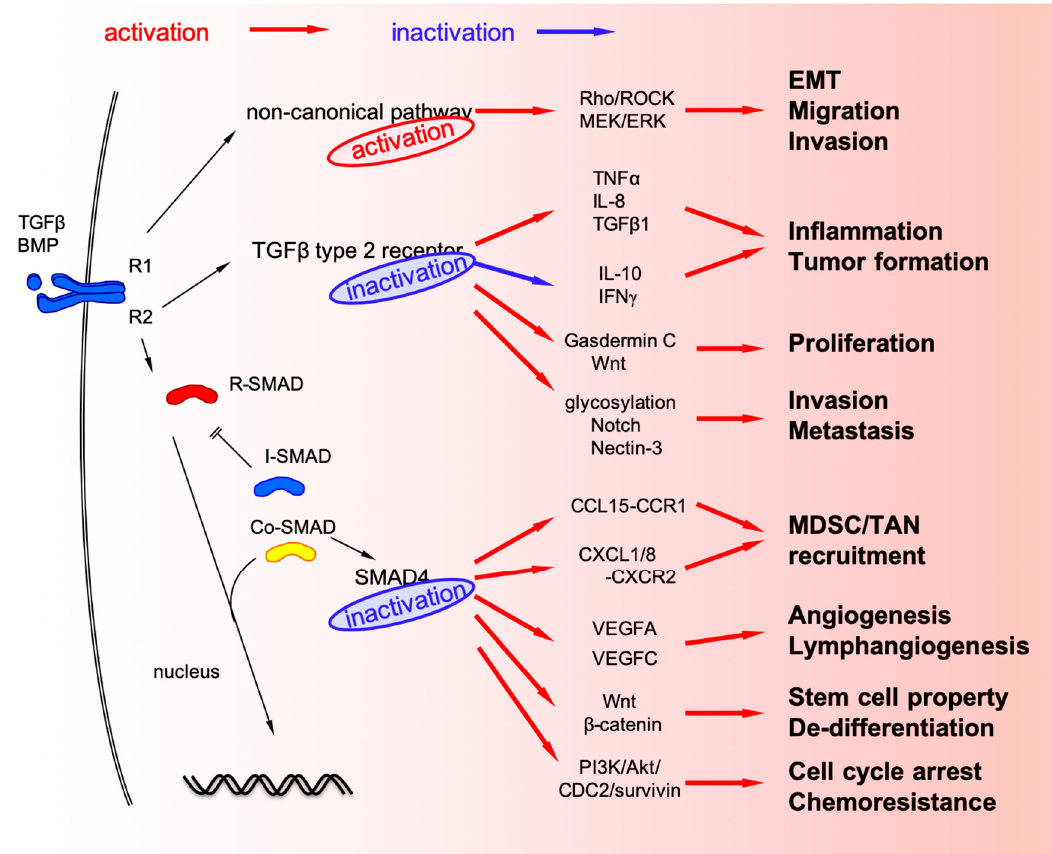
Figure 2. TGF- β alteration in colorectal cancer (CRC) cells.